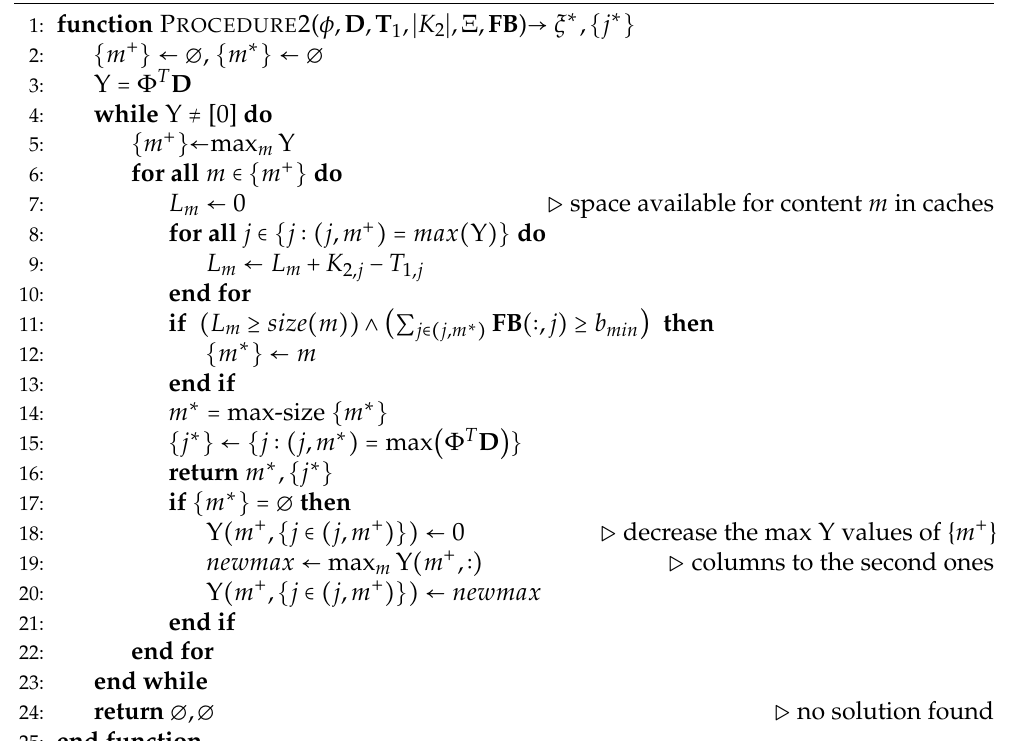
Code 5 Procedure used in A LGORITHM